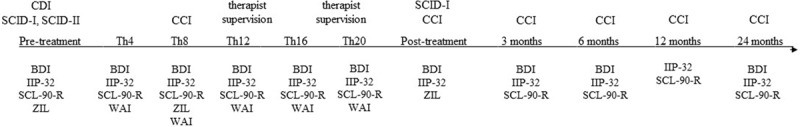
Quantitative self-report (lower half) and interview and qualitative measures (upper half) throughout the research and therapy process.Note: Due to missing values, the total scores for the SCL-90-R at post-treatment and the BDI-II at 12-month follow-up could not be calculated. CDI: Clinical Diagnostic Interview; SCID-I: Structured Clinical interview for DSM-IV axis-I disorders; SCID-II: Structured Clinical Interview for DSM-IV personality disorders; CCI: Clinical Change Interview; BDI: Beck Depression Inventory; IIP-32: Inventory of Interpersonal Problems; SCL-90-R: Symptom Checklist; ZIL: Self-rating Inventory for Post-Traumatic Stress Disorder; WAI: Working Alliance Inventory.